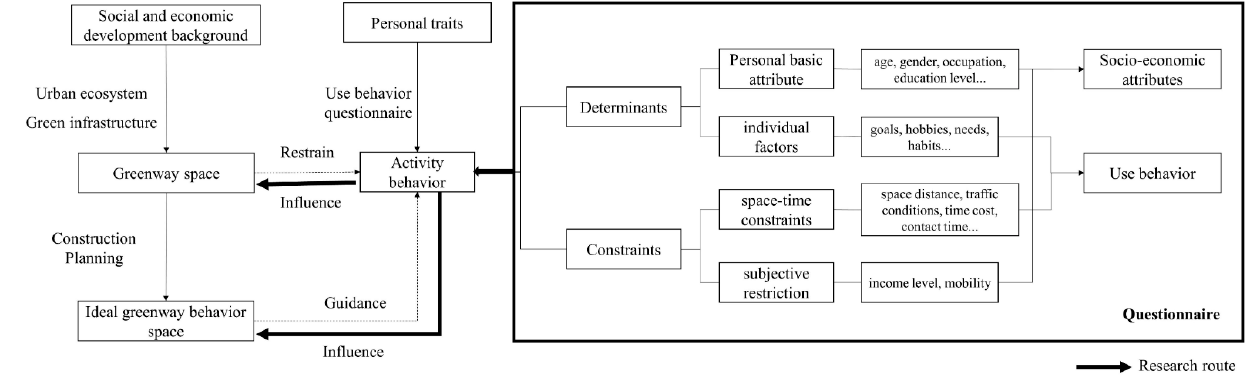
Figure 2. Relationship model of greenway space-user behavior based on the theory of space-behavior. Table 1. Reference indicators of socio-economic attributes.